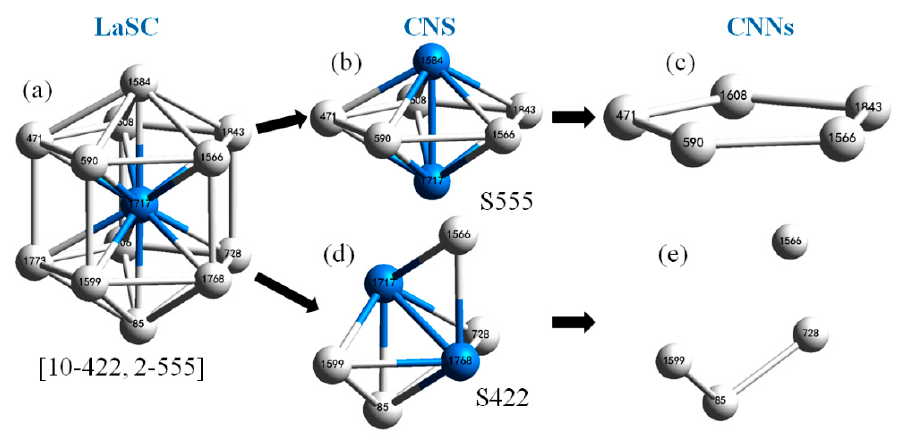
Figure 1. The logical decomposition of a largest standard cluster (LaSC). ( a ) Truncated decahedron (10-422, 2-555); ( b ) CNS S555; ( c ) topology of S555; ( d ) CNS S422; and ( e ) topology of S422.